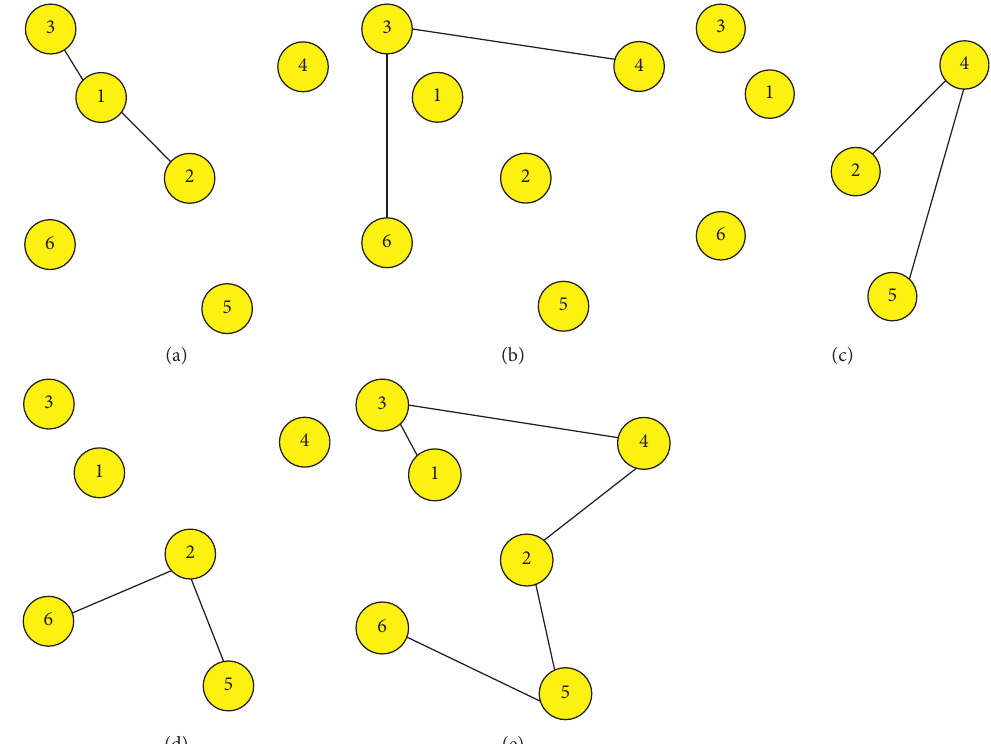
Figure 5: The situation of the traditional ant colony algorithm in the early